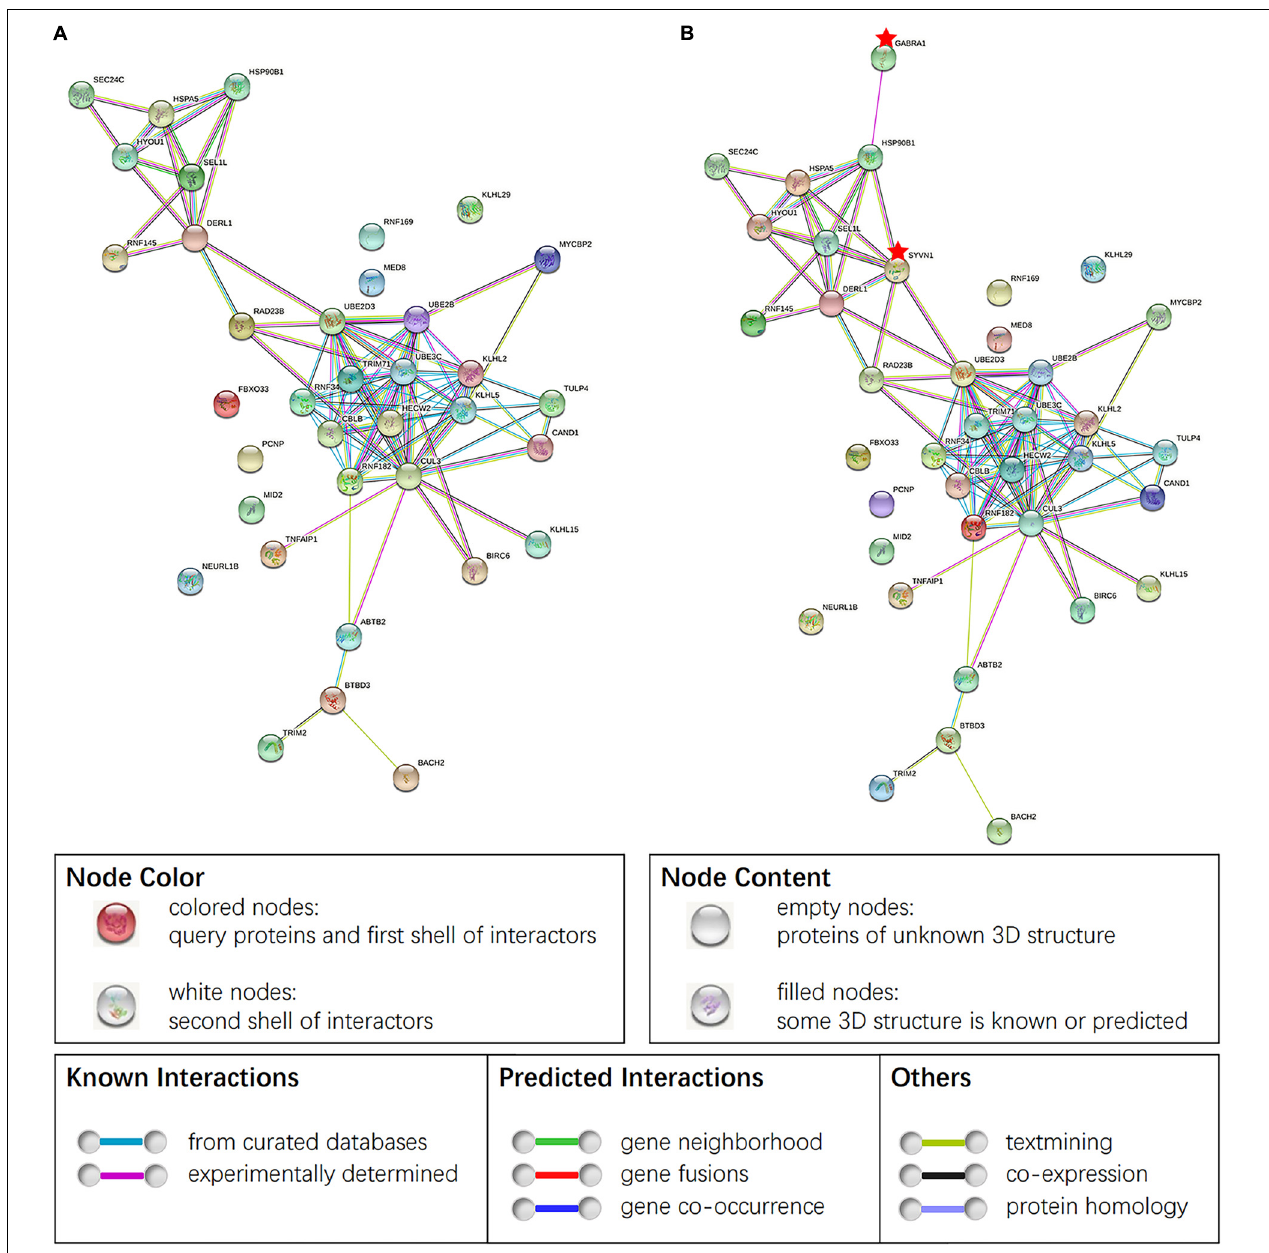
FIGURE 6 | (A) PPI of 36 target genes of miR-181a-5p. (B) PPI obtained by taking SYVN1 and GABAA α 1 together with 36 genes in STING analysis. Network nodes represent proteins, proteins splice isoforms or post-translational modifications are collapsed, i.e., each node represents all the proteins produced by a single, protein-coding gene locus. Edges represent protein-protein associations, associations are meant to be specific and meaningful, i.e., proteins jointly contribute to a shared function. Genes marked the little red pentagram were SYVN1 and GABAA α 1. Figure was cited from STRING online